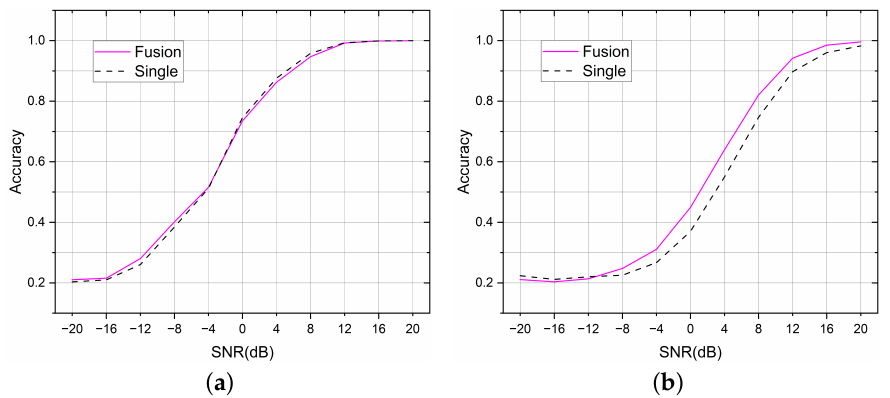
Figure 9. For the AMSCN models, multitask training is more effective than single-task training. ( a ) Comparison of the fusion method and the single-head method in the AMC tasks. ( b ) Comparison of the fusion method and the single-head method in the SEI